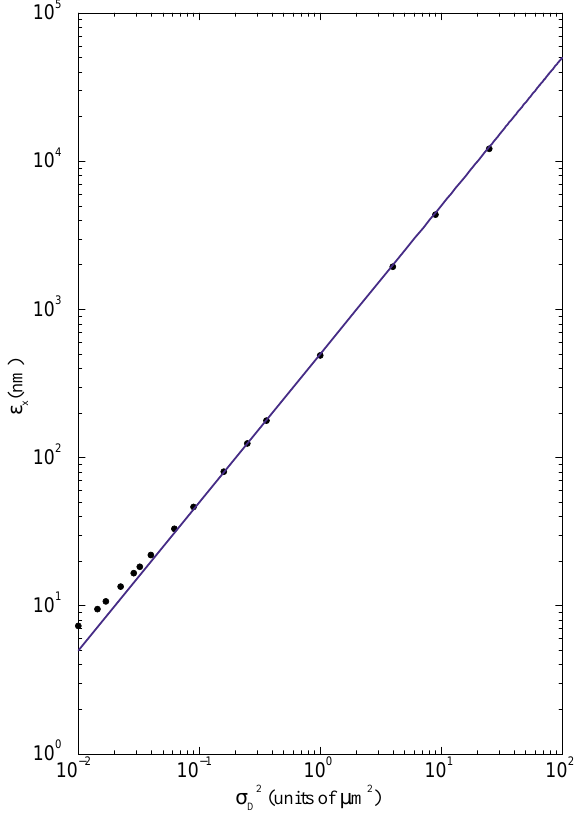
FIG. 7. (Color) Emittance degradation versus s 2 D . A fit to the linear behavior is given to guide the eye [see Eq.